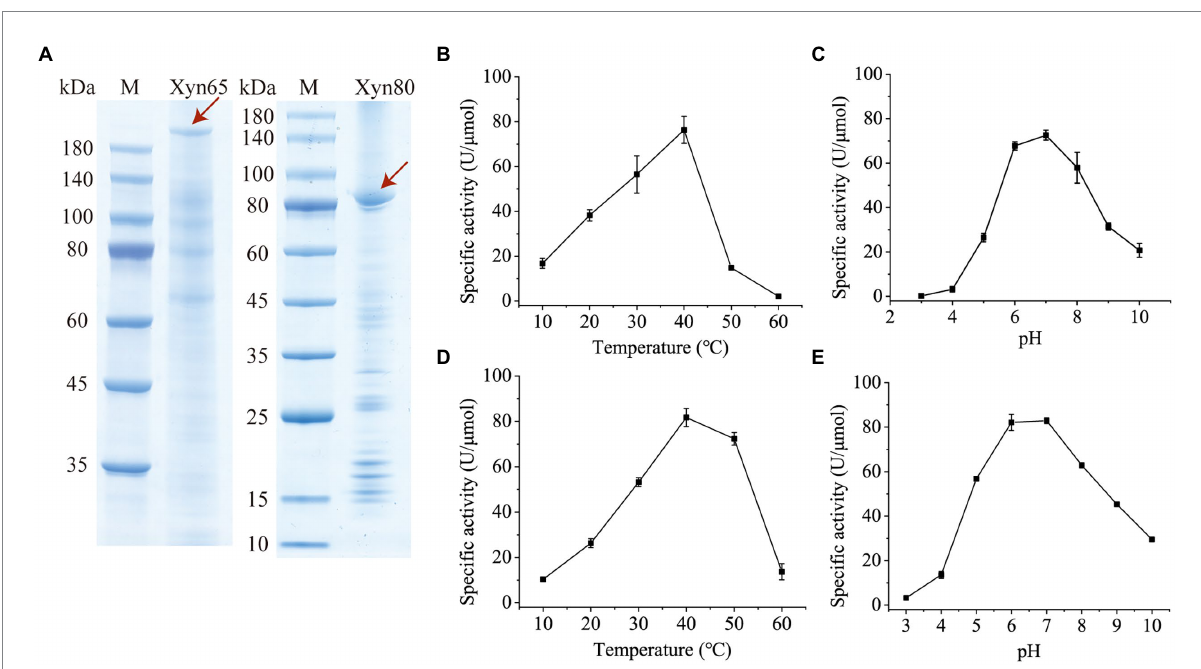
FIGURE 5 SDS-PAGE analysis and biochemical characterization of recombinant 1,3-xylanases Xyn65 and Xyn80. (A) SDS-PAGE analysis of Xyn65 and Xyn80. The enzyme bands are indicated by red arrows. M, protein molecular weight marker. (B) Effect of temperature on Xyn65 activity. (C) Effect of pH on Xyn65 activity. (D) Effect of temperature on Xyn80 activity. (E) , Effect of pH on Xyn80 activity. In B and D, the 1,3-xylanase activities were determined in PBS (pH 7.0) from 10 ° C to 60 ° C. In C and E, the 1,3-xylanase activities were determined in the Britton-Robinson buffer with different pH values (pH 3.0–10.0). The data shown in the graph are from triplicate experiments (mean ±